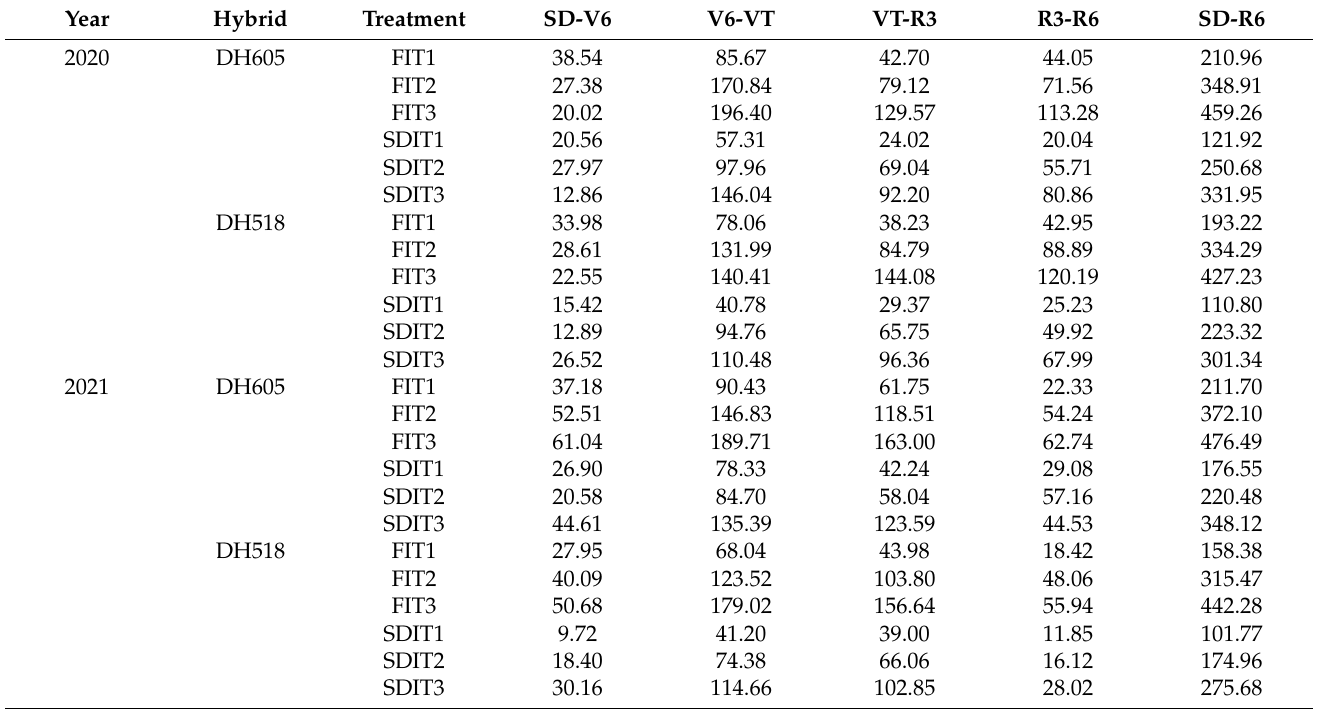
Table 3. Irrigation amounts of two corn hybrids differing in maturity under different irrigation treatments